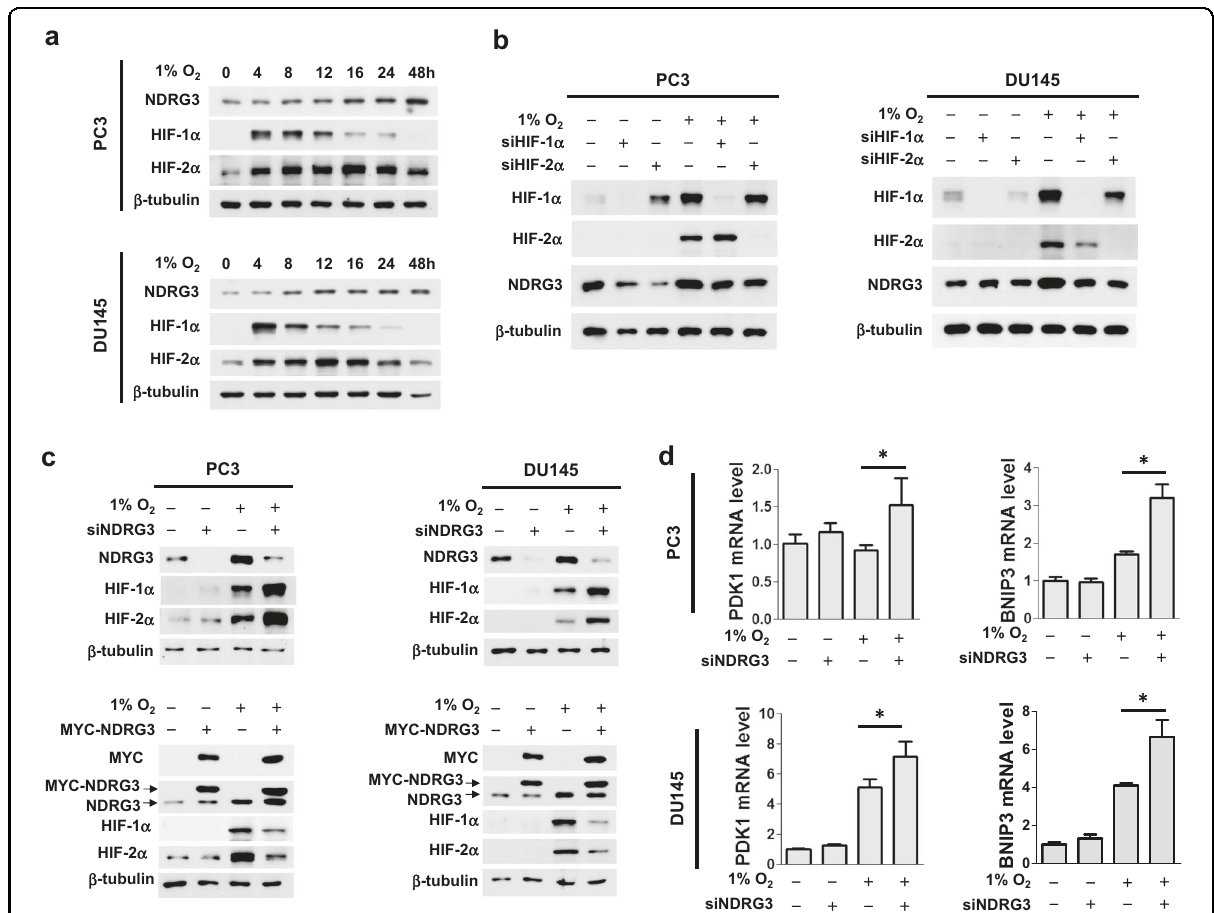
Fig. 1 NDRG3 suppresses the hypoxic induction of HIF-1/2 α proteins. a PC3 and DU145 cells were incubated under hypoxia (1% O 2 ) for the indicated times and subjected to western blotting with an anti-HIF-1 α or anti-HIF-2 α antibody. b PC3 and DU145 cells, which had been transfected with siRNAs silencing HIF-1 α or HIF-2 α , were incubated under normoxia or hypoxia for 24 h and subjected to western blotting. c PC3 and DU145 cells, which had been transfected with NDRG3-silencing siRNA (siNDRG3 #1), were incubated under normoxia or hypoxia for 24 h and subjected to western blotting. d PC3 and DU145 cells, which had been transfected with NDRG3-silencing siRNA, were incubated under normoxia or hypoxia for 24 h and lysed for RNA extraction. PDK1 and BNIP3 mRNA levels were measured by RT-qPCR. Each bar represents the mean + s.d. ( n = 3) and * denotes P < 0.05 between the indicated